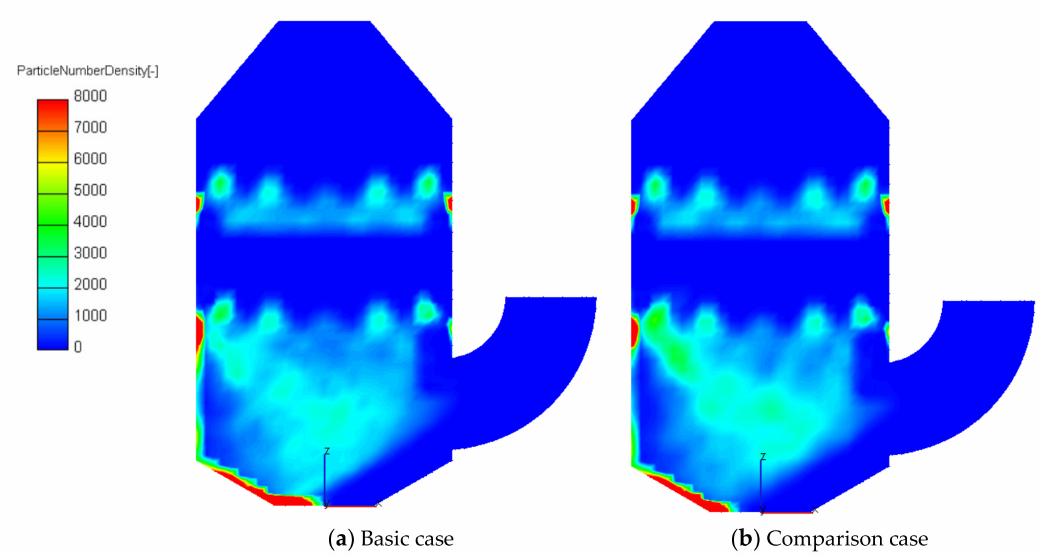
Figure 15. Distribution of the spray droplets.